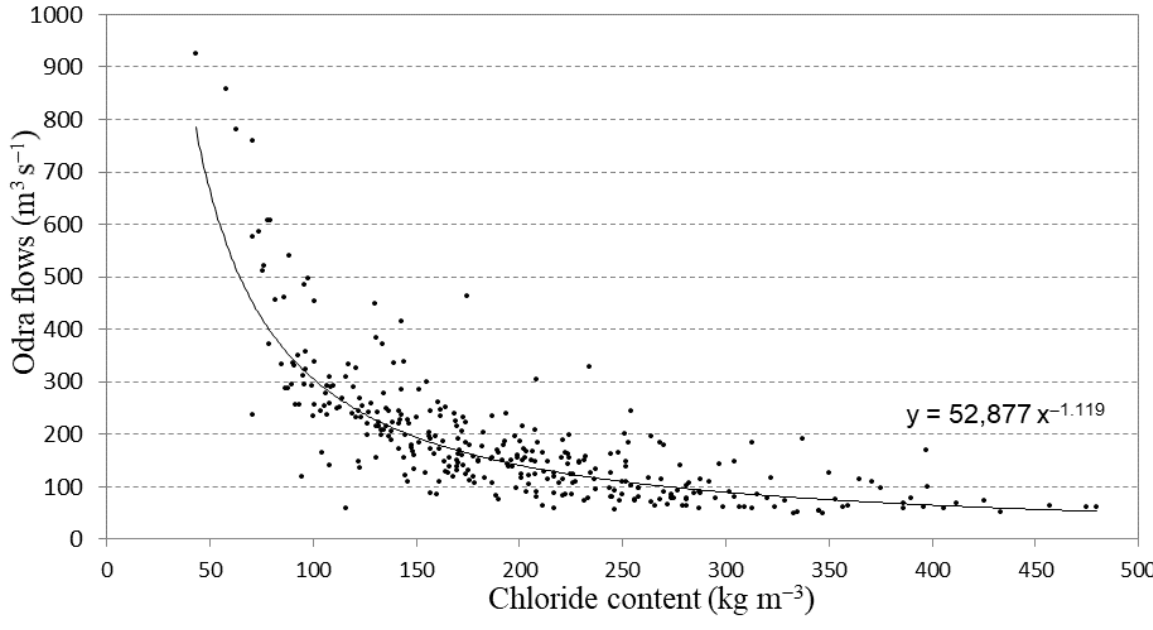
Figure 5: The relationship between the flow of the Odra River and its natural